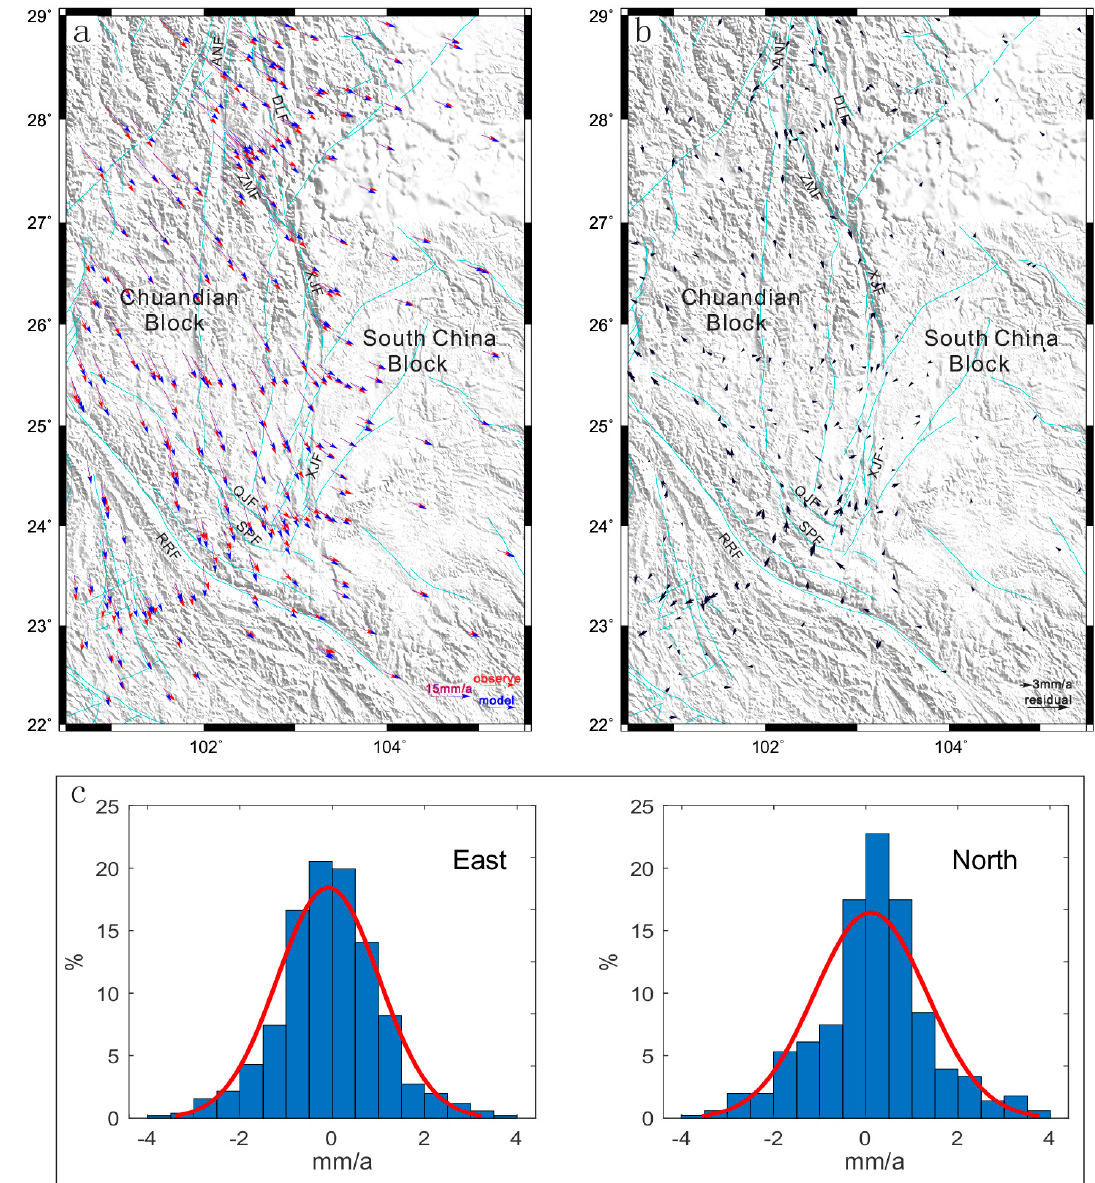
Figure 5. Comparison of the observed velocity vectors with those predicted by the inverted model (blue). ( a ) The observed (red) and predicted (blue) velocity vectors; ( b ) the residual velocity vectors; ( c ) histograms of the residual distribution of the east and north components together with the best approximation of the normal distribution.